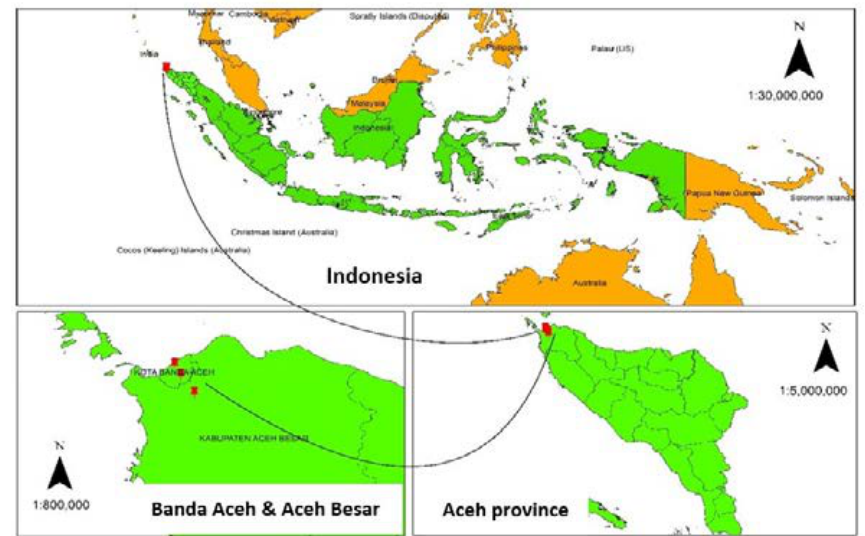
Fig. 1: Geographic location of the Indonesian archipelago showing the sampling location (red dots) from the river mouth to agricultural plantations